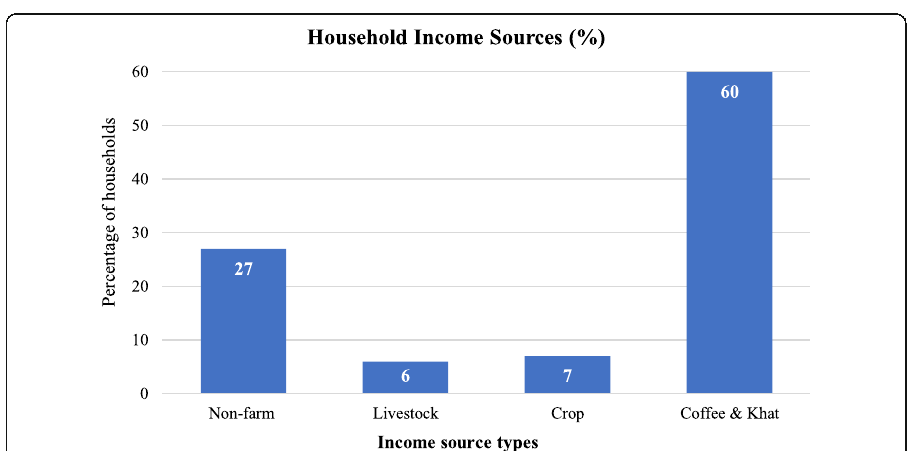
Fig. 8 Total household income by types of source. Source: Authors ’ computation using study survey